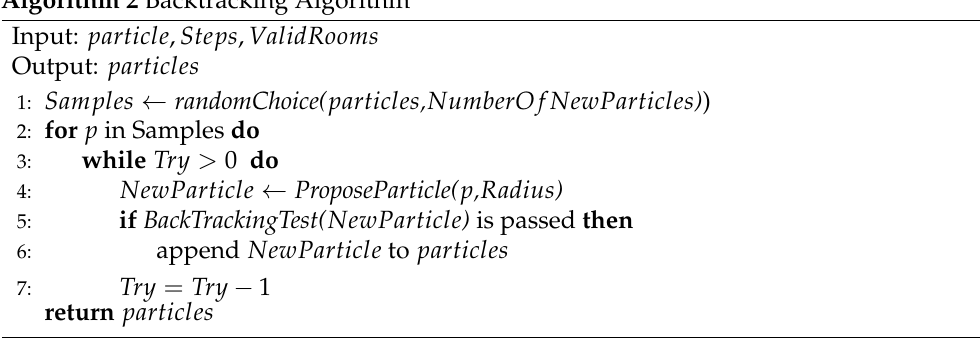
Algorithm 2 Backtracking